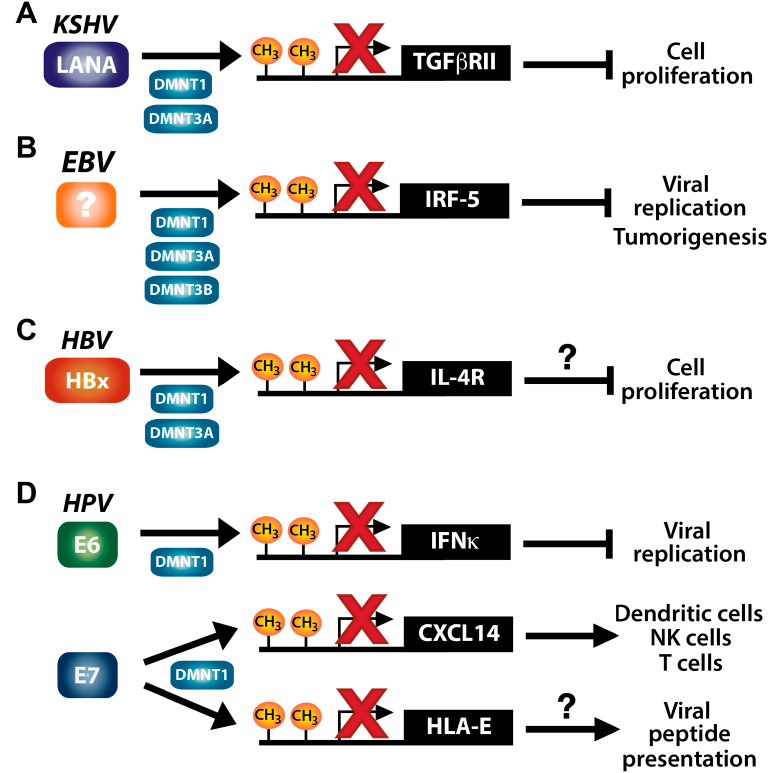
Figure 2. DNA tumor viruses that promote DNA hypermethylation of immune-related genes. ( A ) KSHV LANA; ( B ) an unidentified EBV protein; ( C ) HBV HBx; and ( D ) HPV E6 and E7 proteins